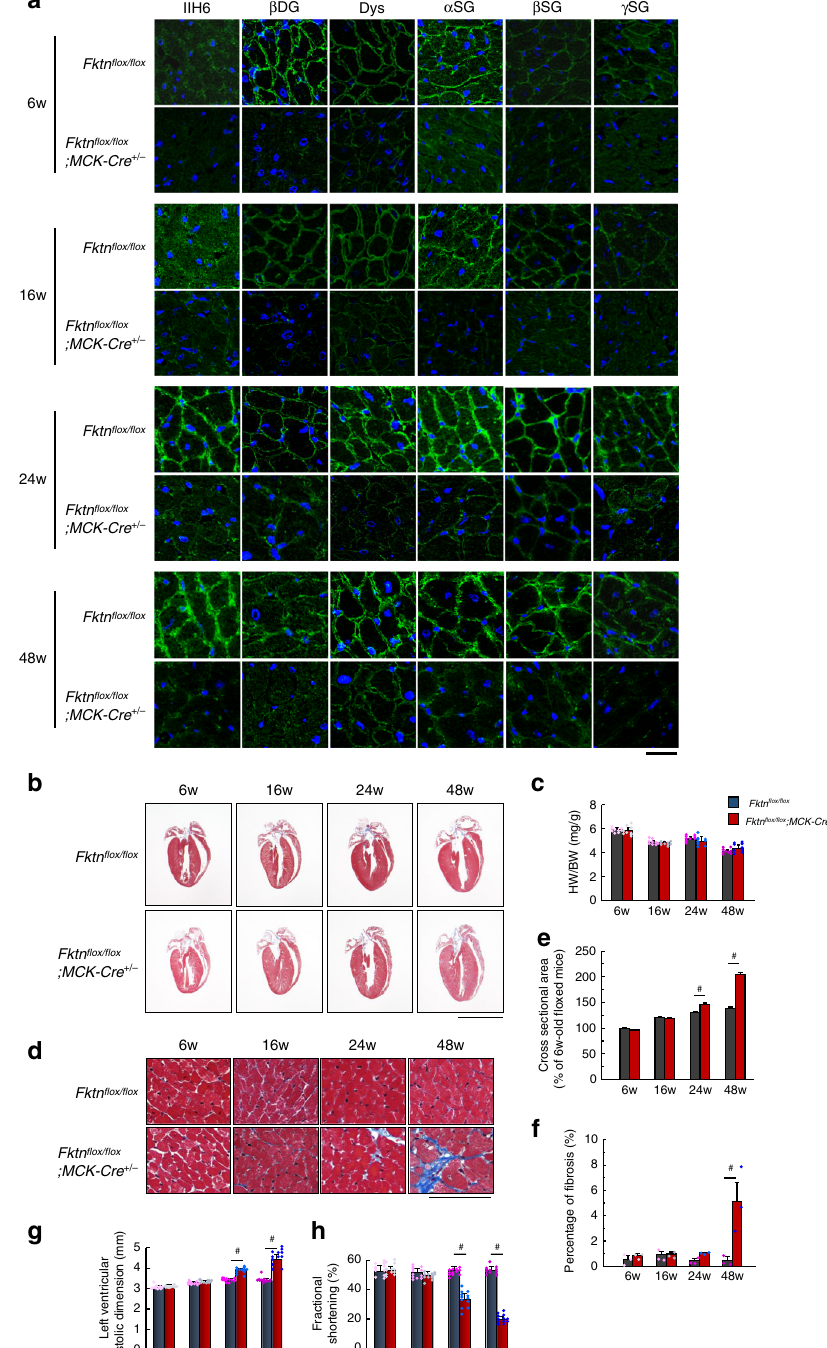
Fig. 1 Cardiac change in MCK- Fktn -cKO ( Fktn fl ox/ fl ox ; MCK-Cre + / − ) mice. a Representative immuno fl uorescent images of DGC complex and glycosylation form of α -DG in control ( fl oxed) and MCK- Fktn -cKO hearts. Anti-IIH6 (glycosylated form of α DG), β DG, dystrophin (Dys), α SG, β SG, and γ SG antibodies (green) and DAPI (blue). Scale bar, 10 μ m. b Cardiac morphology in fl oxed and MCK- Fktn -cKO mice. Scale bar, 5 mm. c Heart weight-to-body weight ratios (HW/BW) ( n = 9 mice per group). d Masson ’ s trichrome staining of the left ventricle. Scale bar, 50 μ m. Cross-sectional areas (6w, n = 259 and 268 cells; 16w, n = 303 and 311 cells; 24w, n = 266 and 287 cells; 48w, n = 283 and 256 cells measured from 3 hearts per group.) ( e ) and fi brosis percentages ( n = 3 mice per group) ( f ) from paraf fi n sections of left ventricles. Echocardiographic parameters of left ventricle diastolic dimension ( g ) and fractional shortening ( h ) in fl oxed and MCK- Fktn -cKO mice ( n = 12 mice per group). Data are means ± s.e.m; # P < 0.05 between indicated groups based on Student ’ s t